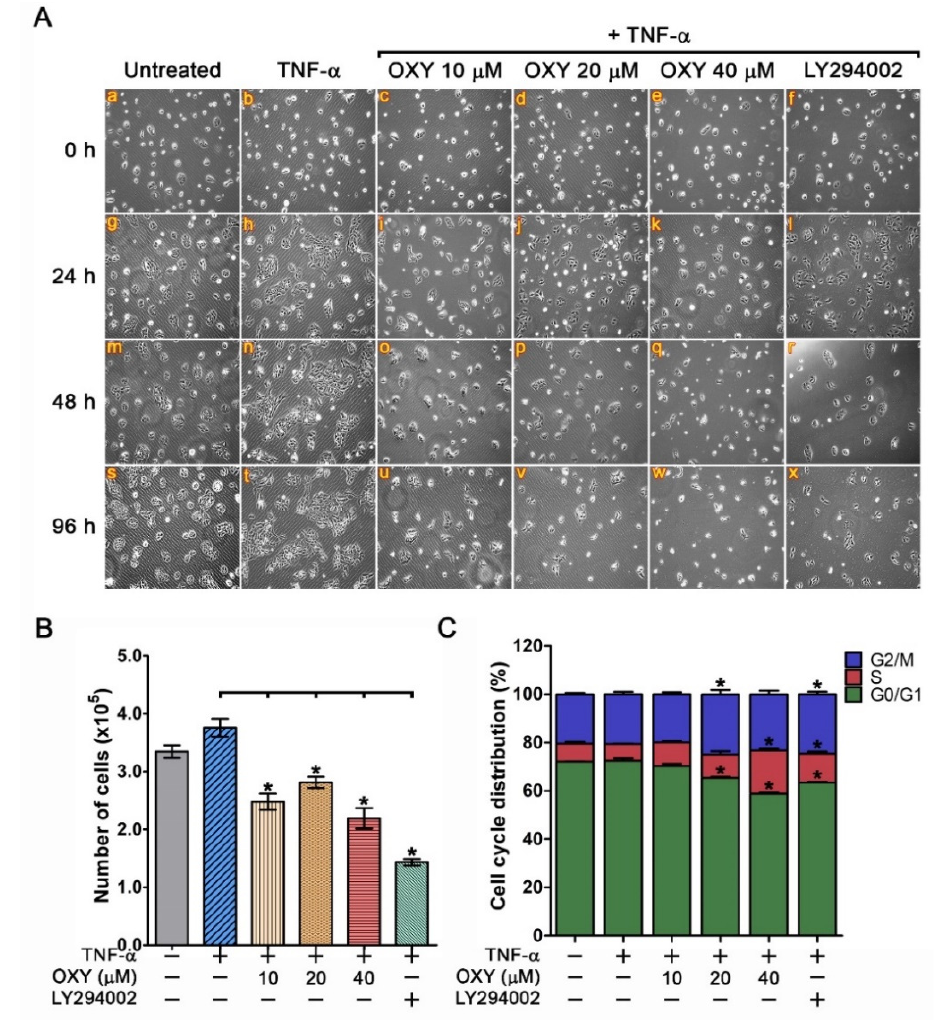
Figure 6. Effects of OXY on TNF- α -induced HaCaT cell proliferation and cycle progress. ( A ) Colony forming assay of HaCaT cells pre-treated with OXY extract at different concentrations (10, 20, and 40 µ M) for 3 h, stimulated with 100 ng/mL of TNF- α for, and observed by a phase-contrast microscope (10 × magnification) at different time points (0, 24, 48, and 96 h). ( B ) Cell counting assay for TNF- α -stimulated HaCaT cells treated with OXY at different concentrations and at different time points. ( C ) Cell cycle analysis indicating the effects of OXY on cell cycle distribution. * p < 0.05 in comparison to the TNF- α -treated